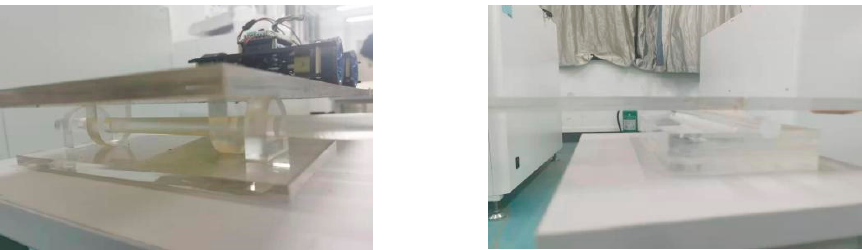
Figure 26. Fixed hinge bearing and sliding hinge bearing.